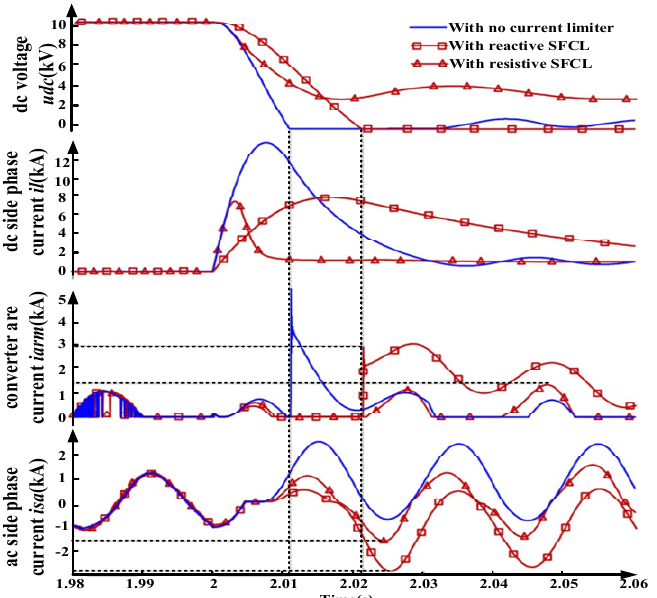
Figure 1. The transient characteristics of the DC fault when the resistive type superconducting fault current limiters (SFCLs) are applied [24].